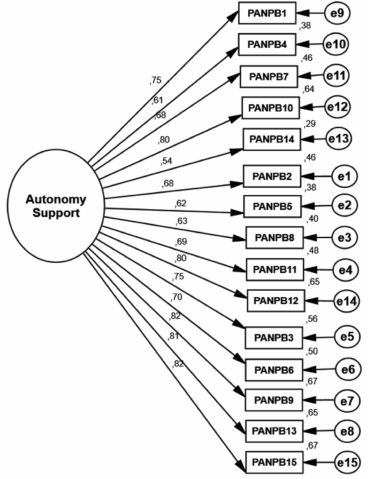
Figure 3. Standardized individual parameters (covariance factors, factorial weights and measurement errors), all of which were significant in the measurement model (PESSp - one factor/15 items) for the Portuguese calibration sample